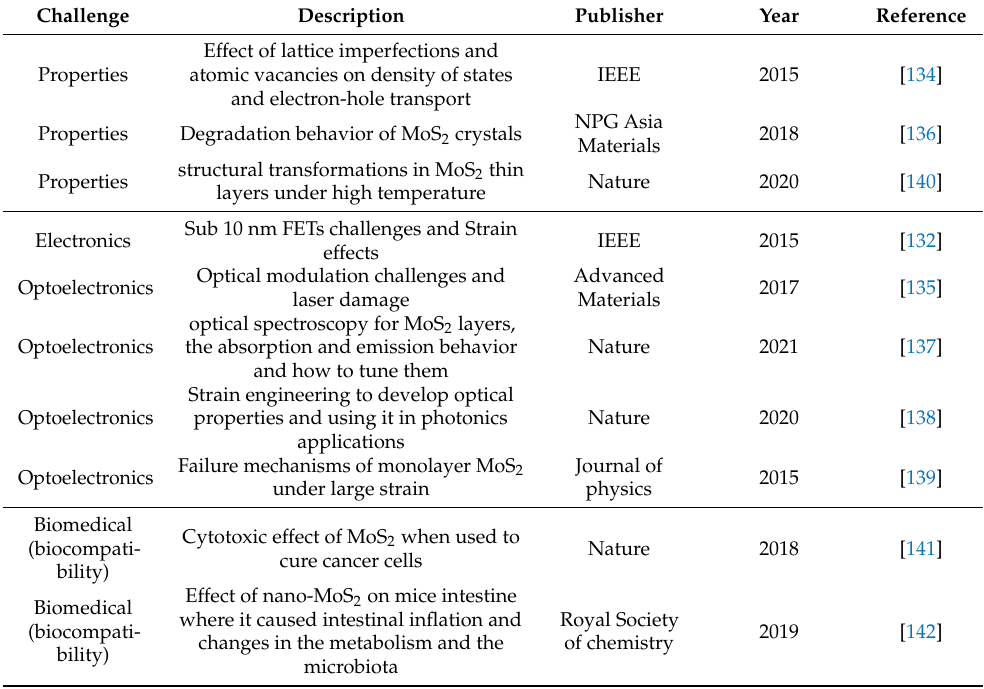
Table 6. Summary of challenges facing MoS 2